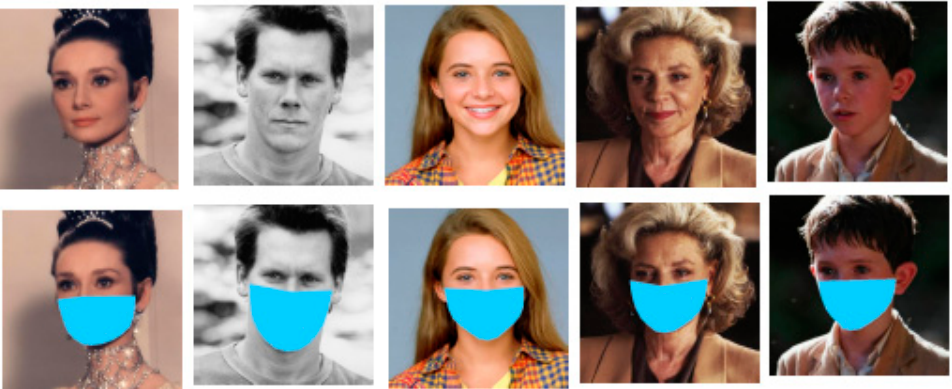
Figure 6. Exemplar images from IMDB-WIKI dataset after face mask overlay.